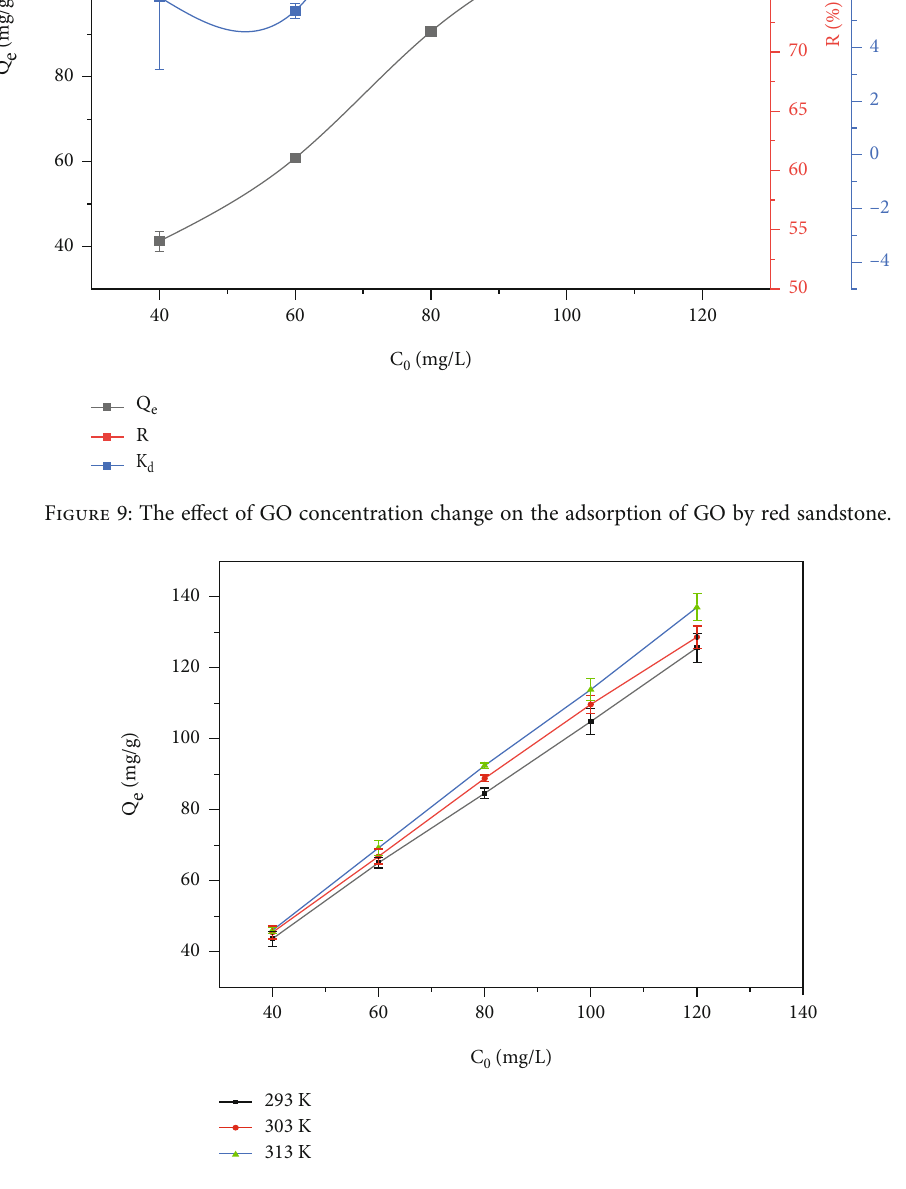
Figure 10: Adsorption isotherm of GO by red